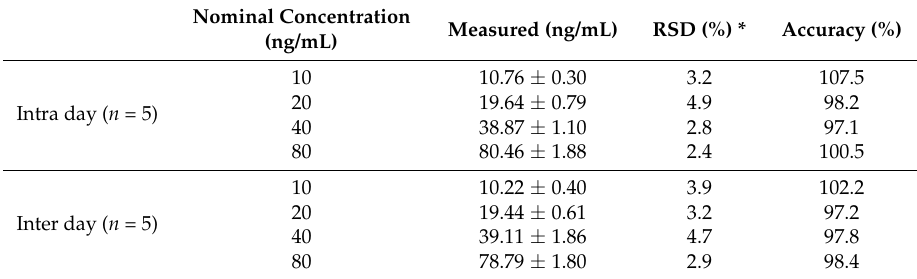
Table 2. Intra-day and inter-day precision and accuracy at different concentrations.